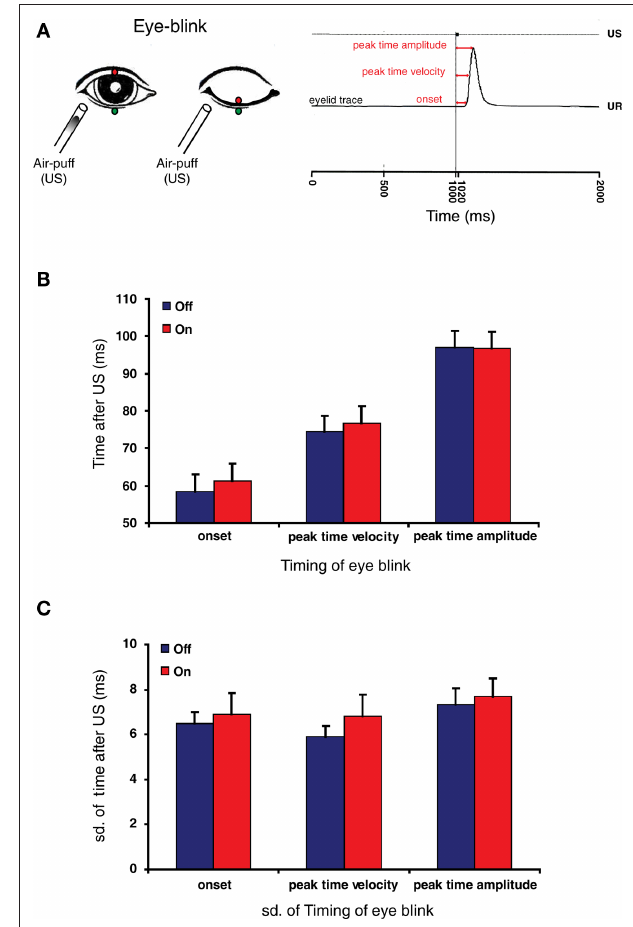
Figure 3 | reflex blinking is not affected by the intake of mefloquine. (A) Left panel: Schematic drawing of eye-blink recording system. A gold plated neodymium magnet was attached to the edge of the upper eyelid (red circle), while a magnetoresistive sensor was attached at the edge of the orbit below the right lower eyelid (green circle). A blink was induced by a small air-puff (unconditioned stimulus: US). An increased magnetic force is detected by the sensor during closure of the eyelid. Right panel: eyelid movement recording of an unconditioned response (UR). Three temporal aspects of the reflex blink were determined: the onset, peak time velocity and peak time amplitude (red arrows). Figure is adopted from Smit et al. (2008). (B) Histogram of eye-blink timing parameters before (blue bars) and 24 h after the intake of mefloquine (red bars). (C) Histogram of standard deviations of the measured eye-blink timing parameters before (blue bars) and 24 h after the intake of mefloquine (red bars). Histograms show mean and SEM ( n =